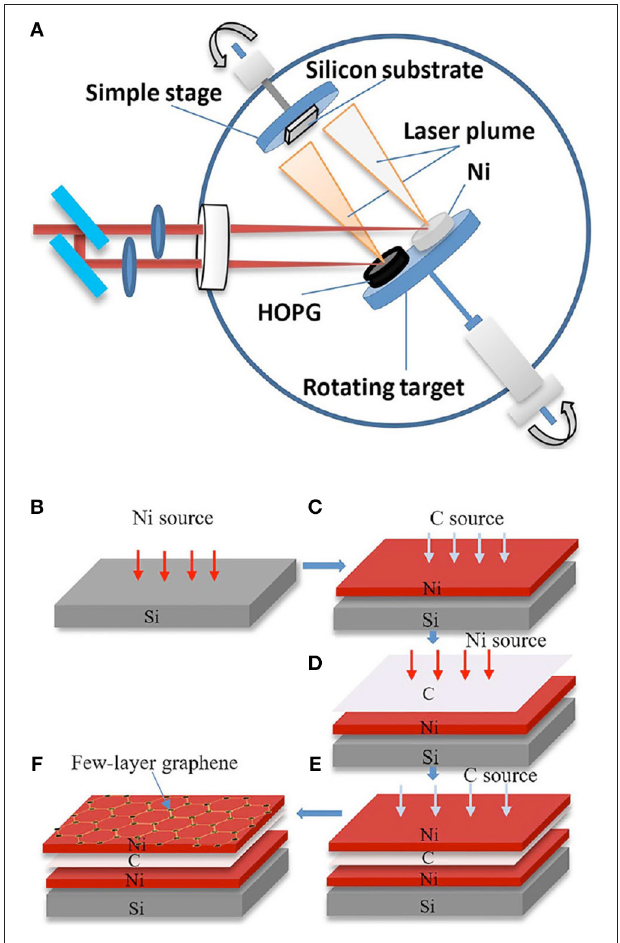
FIGURE 12 | (A) Schematic image of the laser deposition system; steps (B–F) are used in few-layer graphene deposition [Reproduced from Dong et al. (2017) with permission of Springer].